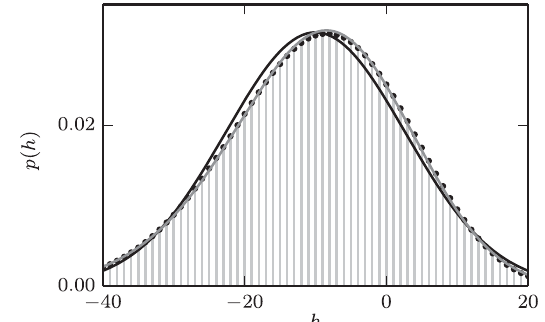
FIG. 3. Distribution of the summed input. Circles show the distribution assuming uncorrelated activity of the input neurons P B ð pN ; m; k Þ B × with constant rate m ¼ 0 . 2 , i.e., p ð h Þ ¼ E k;l , with binomial probabilities B ð N; p; k Þ . We ð pN I ; m; l Þ δ h;J E k þ J I l show the Gaussian approximation N ð μ ; σ 2 ; h Þ (black) with the same moments as the summed binomial distribution μ ¼ p ð N J N J m , σ 2 ¼ p ð N J 2 N J 2 m ð 1 − m Þ . The close- E E þ I I Þ E I E þ I Þ to-Gaussian approximation p ð h Þ ≃ ð 1 þ ð κ 3 = 6 Þ ∂ 3 μ Þ N ð μ ; σ 2 ; h Þ (gray) is shown, taking into account the third cumulant κ 3 ¼ J 3 N J 3 2 m 3 − 3 m 2 þ m Þ of h . Other parameters are p ð N E I E þ I Þð the same as in Fig.